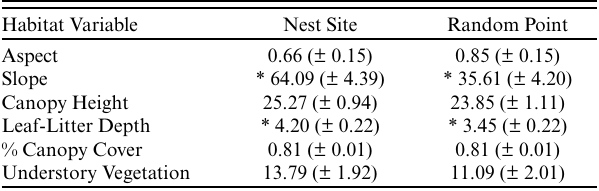
Table 2 . Beers’ aspect, slope, canopy height, leaf-litter depth, percent canopy cover, and understory vegetation density values at Worm-eating Warbler ( Helmitheros vermivorum ) nest sites and random points in southern Indiana in 2015-2017 (mean ± standard error). Asterisks indicates a significant difference in means (P ≤